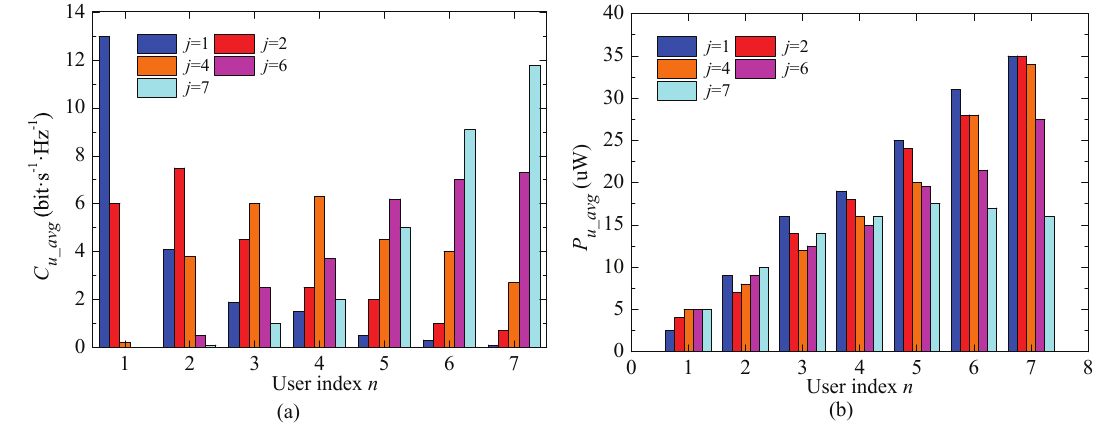
Figure 4. The average system capacity and the total collected energy of single user obtained by IS2M in the Nakagami- m fading channel N = 7 and m = 3. ( a ) ECC of single user; ( b ) ACE of single user.